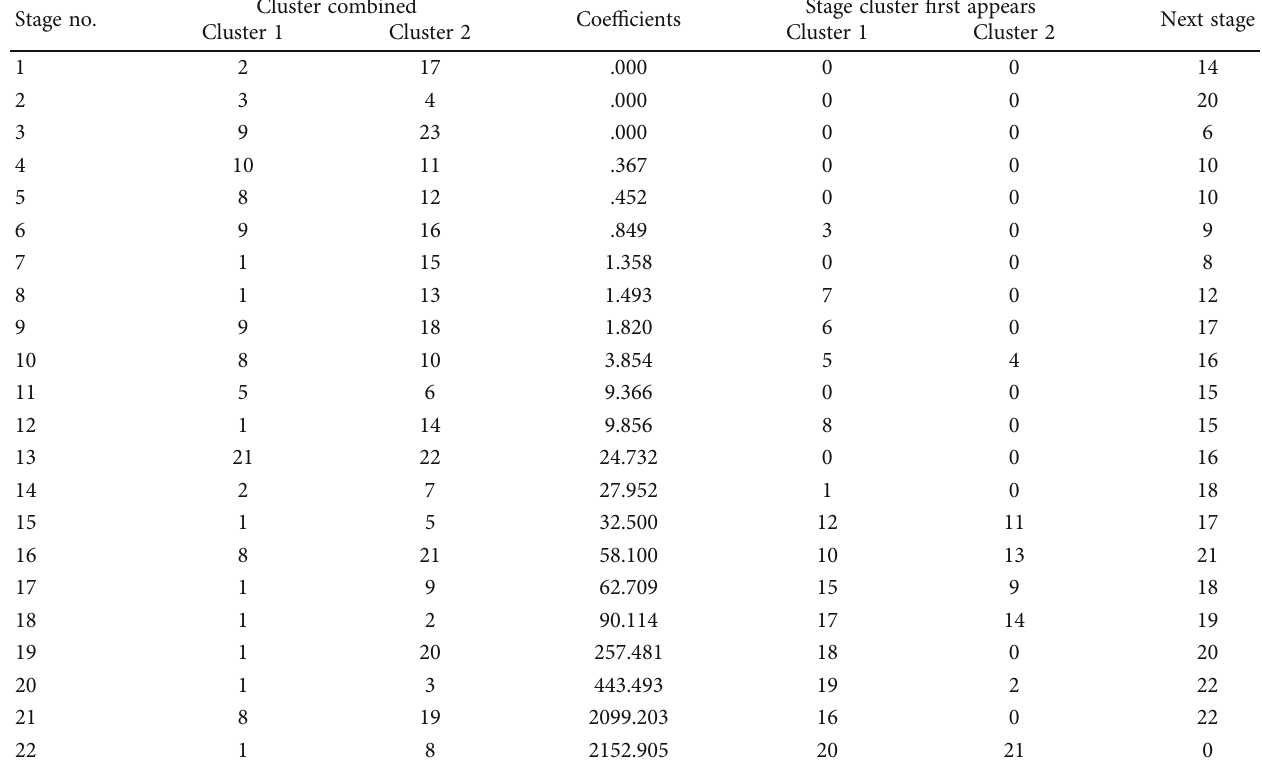
Table 4: Agglomeration clustering schedule.